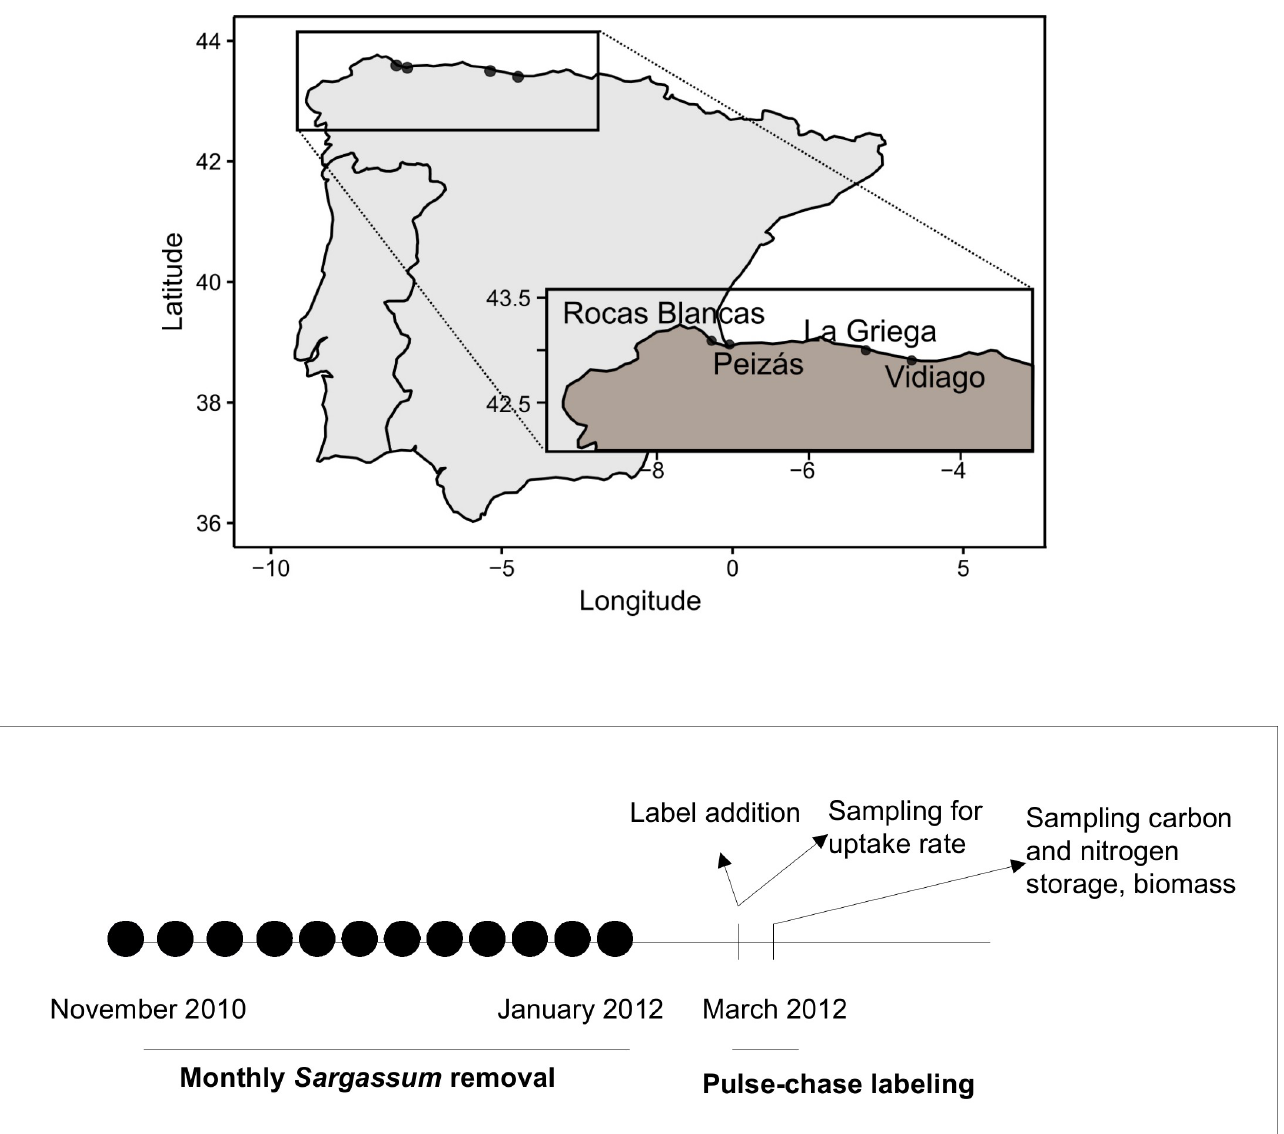
Fig 1. Study sites and sampling design. Map of the sites on the Spanish coast: Rocas Blancas (RB), Peizas (P), La Griega (LG), Vidiago (V) and timeline of the experiment.